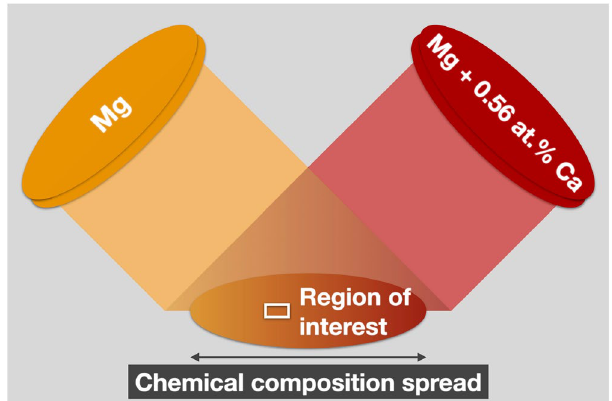
Figure 1. Combinatorial growth of (Mg,Ca) solid solutions with a chemical composition spread induced by the co-sputtering geometry. An elemental magnesium as well as a cast calcium-alloyed magnesium target with a calcium concentration of 0.56 at% were used. The chemical composition spread on the substrate is indicated by the colour gradient and the region of interest for microstructural as well as chemical composition analysis at the nanometre scale is indicated by the rectangular